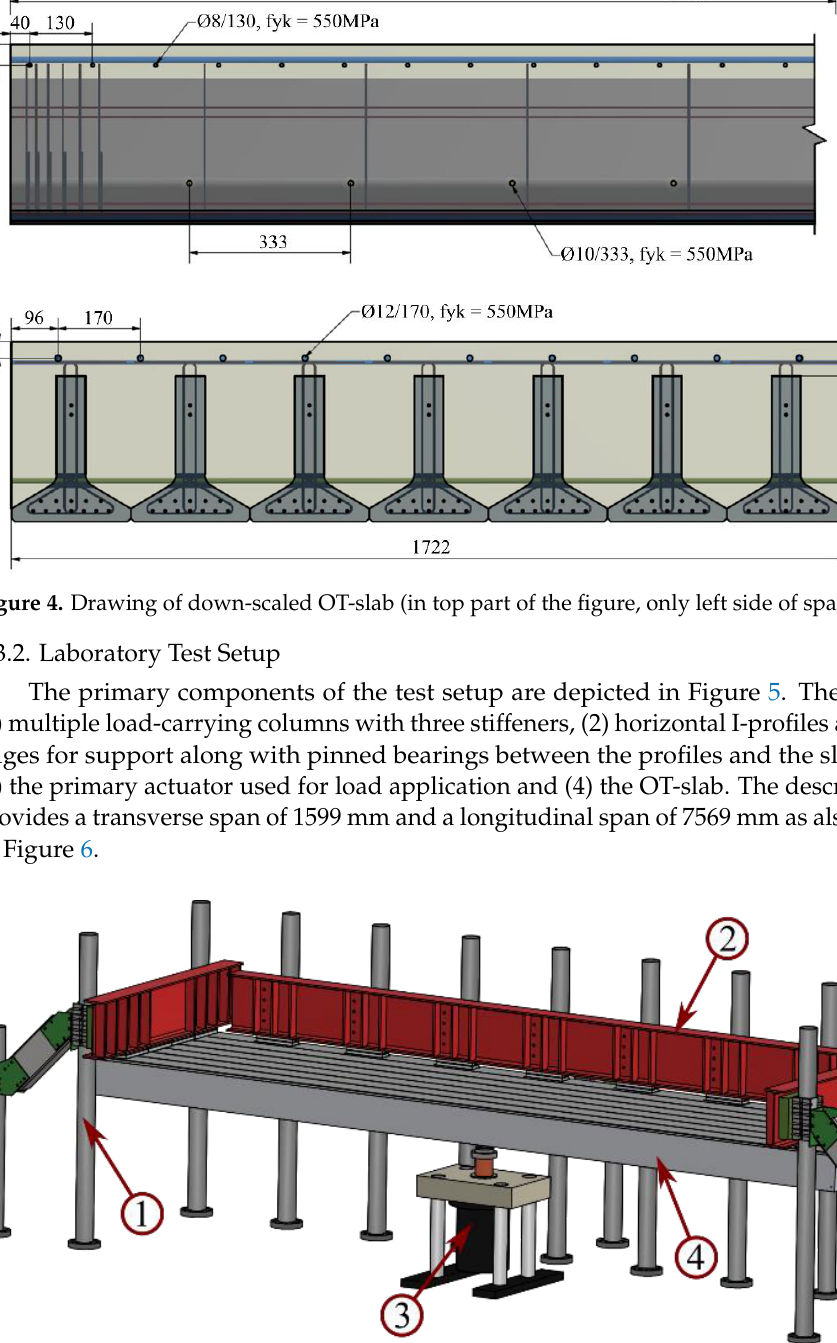
Figure 6. The laboratory test setup viewed from above with loading point and DIC coverage indicated. 2.3.3. Laboratory Test Monitoring The monitoring setup consisted of LVDTs, wire potentiometers and distance lasers for deflection measurements, strain gauges for strain monitoring in the transverse rein- forcement and 2D DIC for full field surface evaluation of deformations and cracks. An independent monitoring rig was constructed around the test setup with no physical con- tact between the two, as seen in Figure 7. Consequently, all measurement devices could